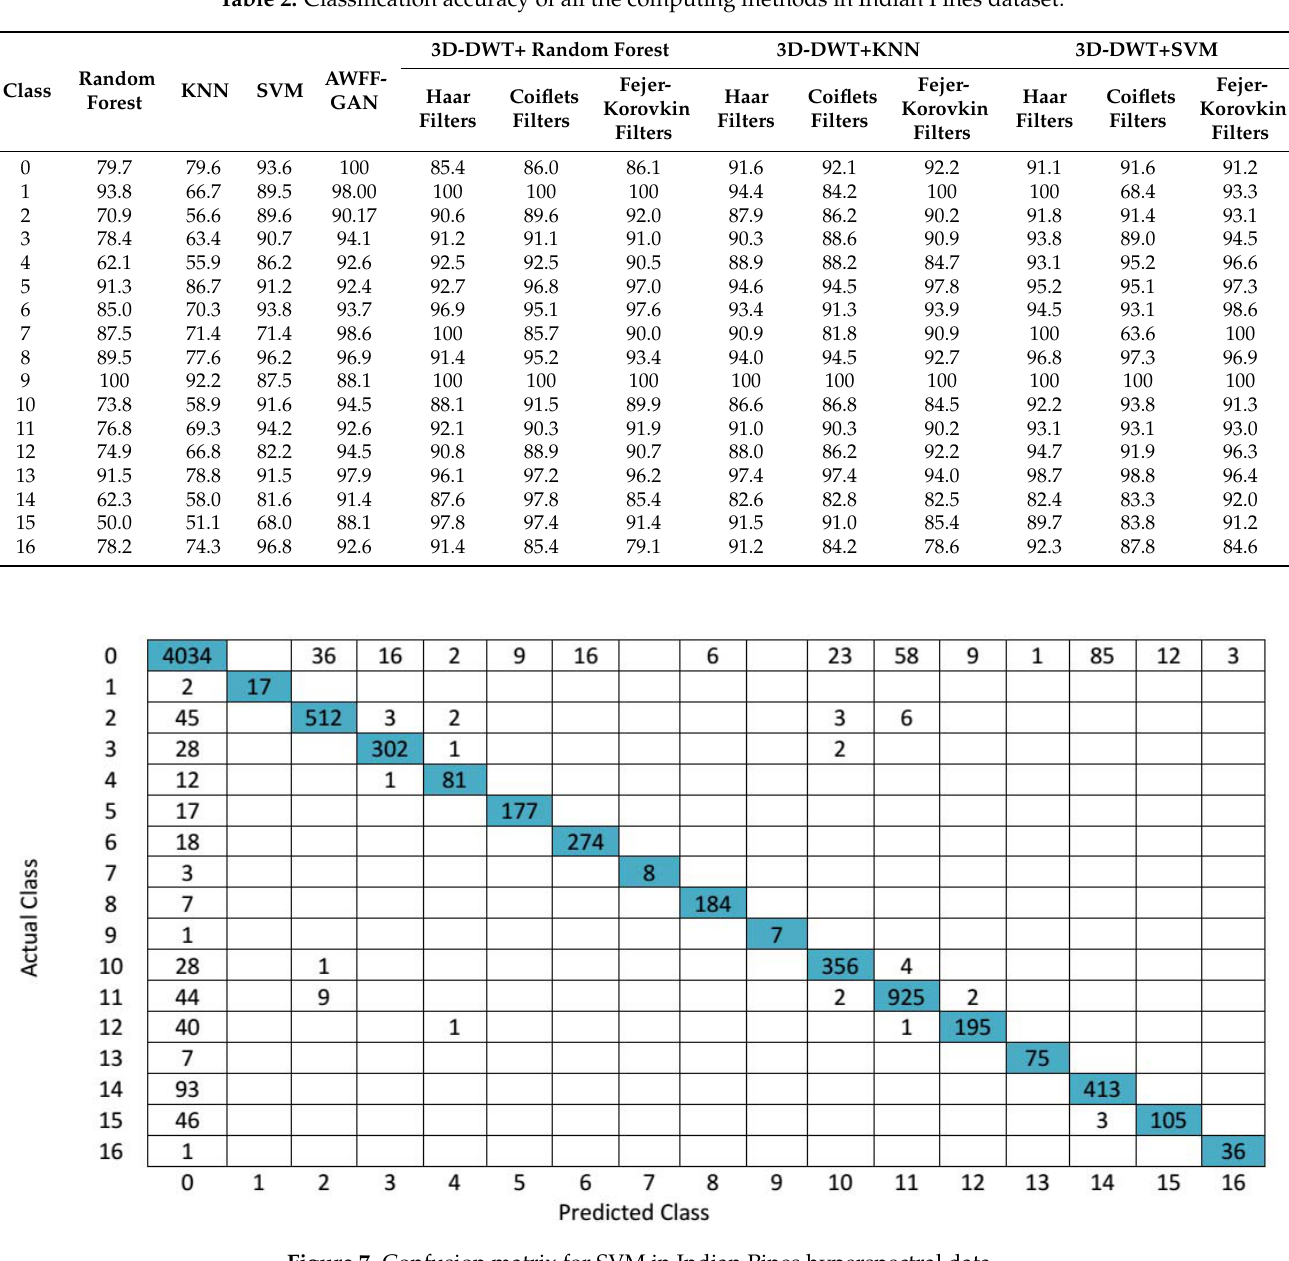
Figure 7. Confusion matrix for SVM in Indian Pines hyperspectral data. The proposed 3D-DWT features-based classifiers perform better compared to existing algorithms. The overall accuracy of test data is achieved SVM (77.1%), KNN (60.2%), random forest (67.7%), 3D-DWT+KNN (79.4%) and 3D-DWT+random Forest (76.2%) are less than the 3D-DWT+SVM method’s (88.3%) relative accuracy by 14.5, 46.7, 30.4,